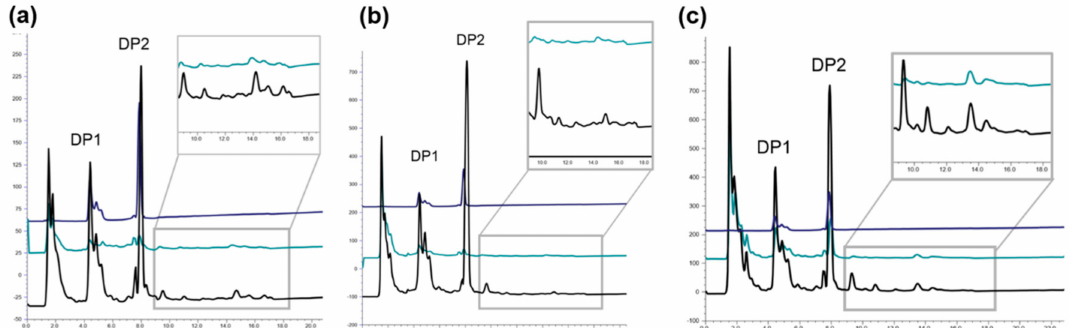
Figure 6. High Performance Anion-Exchange Chromatography with Pulsed Amperometric Detection (HPAEC-PAD) chromatograms for the detection of LPMO activity. ( a ) P. citrinopileatus , ( b ) G. resinaceum , ( c ) A. biennis . Dark blue line : glucose and cellobiose controls, light blue line : reaction control with deactivated enzyme, black line : reaction of crude enzyme with PASC substrate. DP1: glucose, DP2: